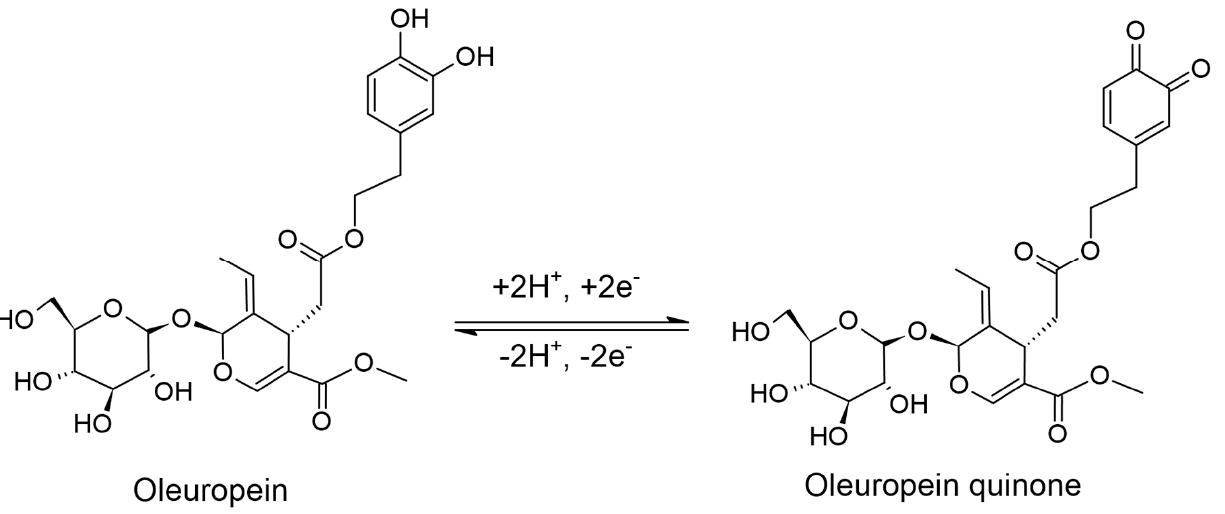
Scheme 2. Reversible oxidation mechanism of oleuropein.